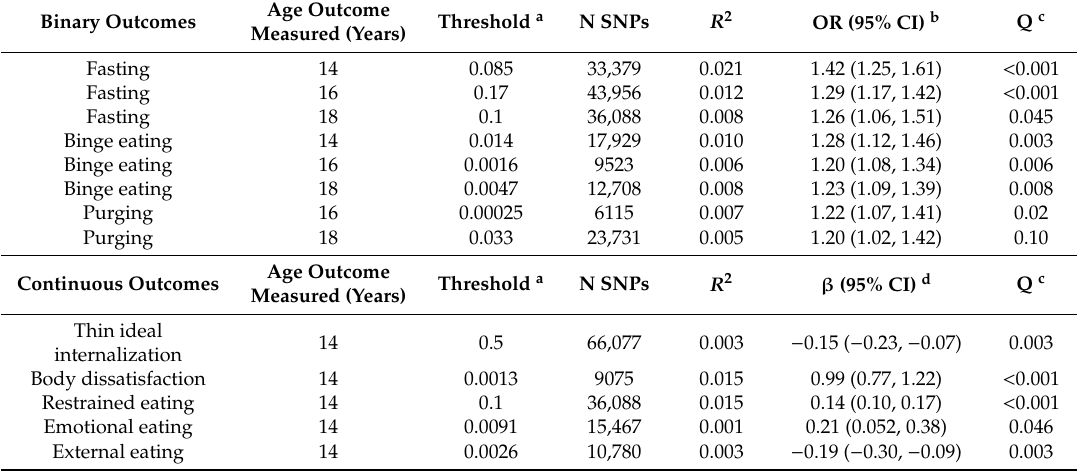
Table 2. Associations of body mass index polygenic score (BMI-PGS) with disordered eating behaviors and cognitions correcting for biological sex in the Avon Longitudinal Study of Parents and